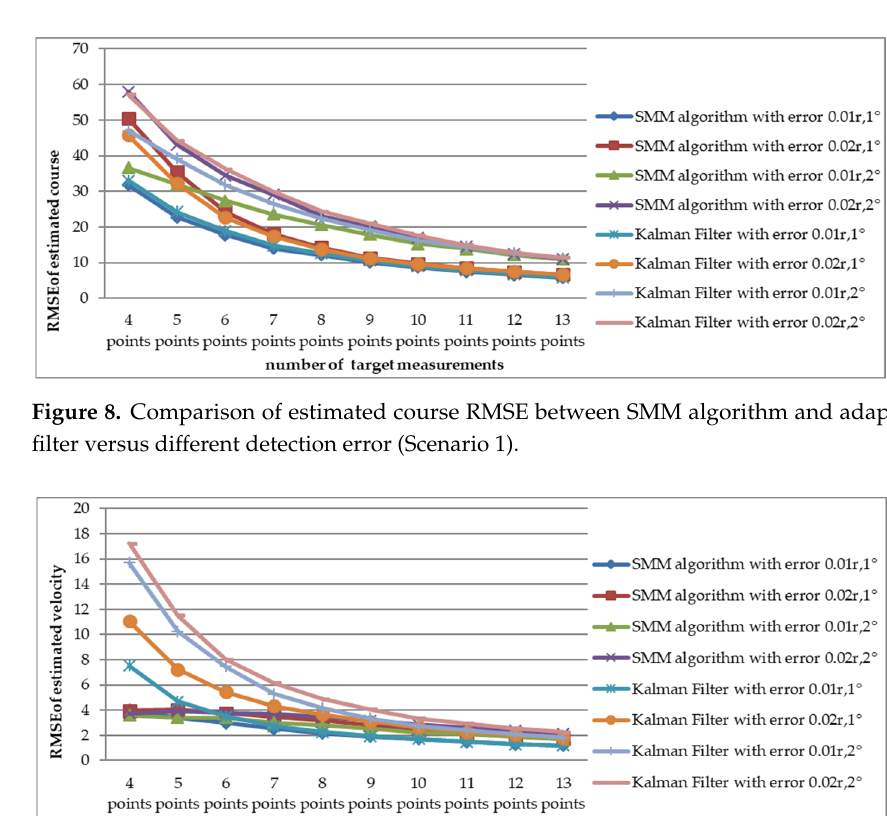
Figure 10. Comparison of estimated course RMSE between SMM algorithm and adaptive Kalman filter versus different detection error (Scenario 7). 5.2. Simulation of AOU estimation In order to show the effectiveness of AOU estimation algorithm, the simulation is carried out. The simulation condition is the same to the state estimation simulation with scenarios in Table 1. The movement situation of Scenario 1 with the detection error